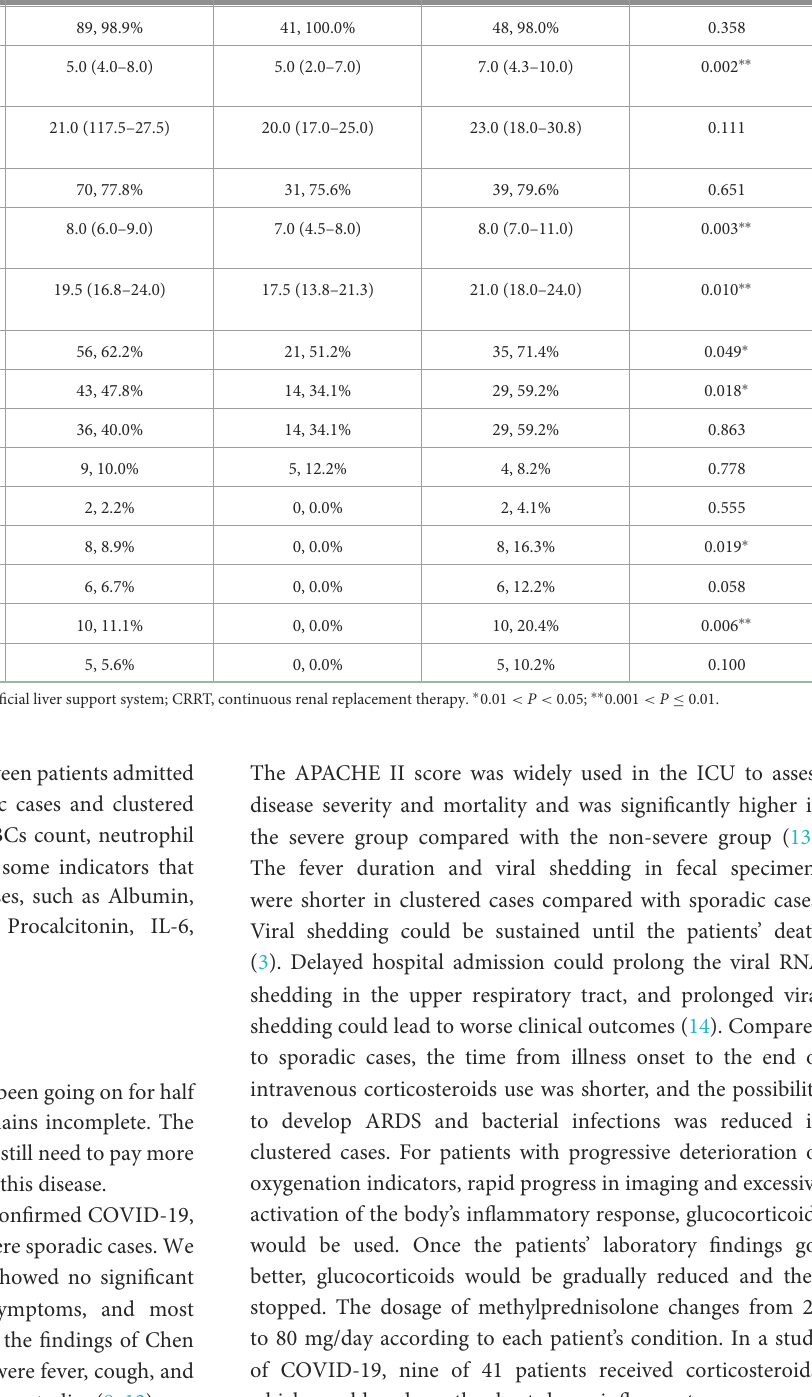
TABLE 2 Clinical treatments of 90 patients with laboratory confirmed coronavirus disease 2019 infection. Treatments All patients ( n =